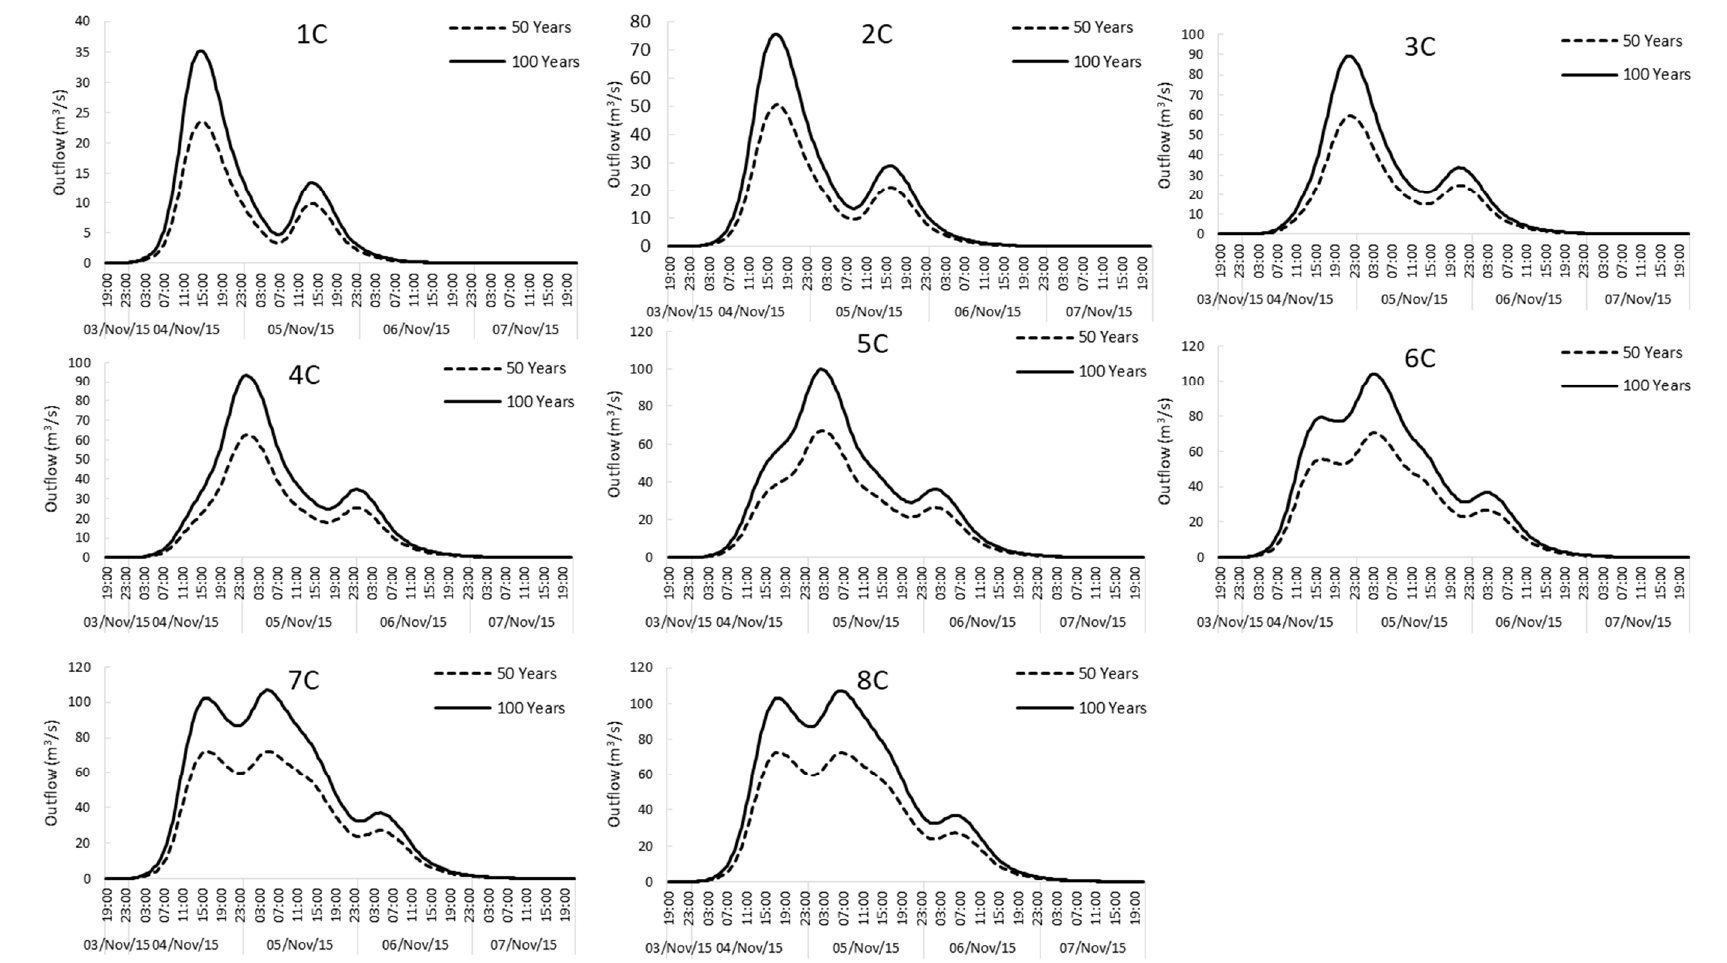
/ Date for 50-year and 100-year return Figure 7. Streamflow vs Time/Date for 50-year and 100-year return periods. Figure 7. Streamflow vs Time